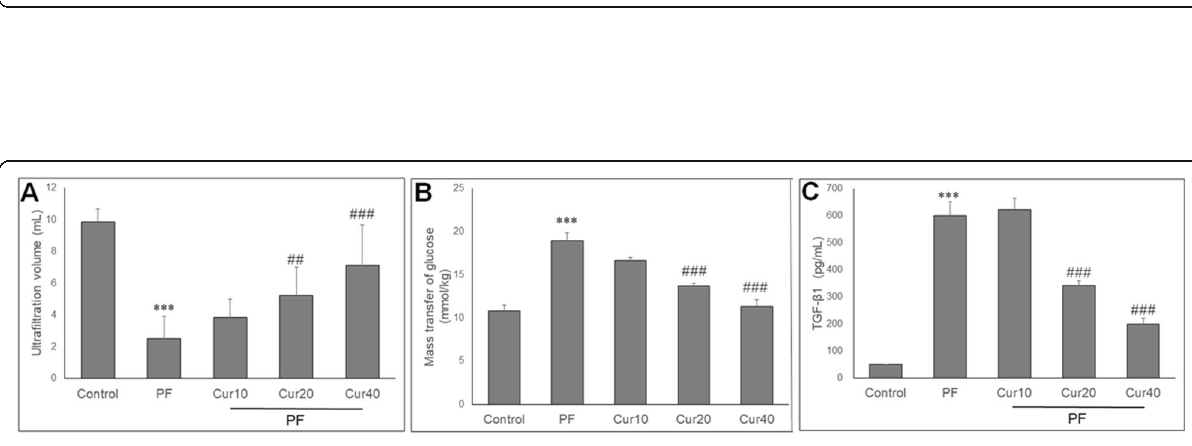
Fig. 1 Effects of Curcumin on the peritoneal thickness of PF rats. Peritoneum was stained with Masson ’ s trichrome to measure the thickness of submesothelial zone. Representative photomicrographs of peritoneal samples was shown. a Control rats showed a thin submesothelial layer of peritoneum, without any morphological changes. b PF rats showed a marked thickening of the submesothelial compact zone. Curcumin prevented the thickening of submesothelial zone with low ( c ), moderate ( d ) and high ( e ) doses. d Quantification analysis of the effect of curcumin on peritoneal thickness. Bar, 100 μ m. Magnification, 200×. Data are represented as means ± SD for 12 rat of each group. ANOVA was performed and followed with Tukey ’ s post hoc test. *** P < 0.001 vs. control group; ### P < 0.001 vs. PF group